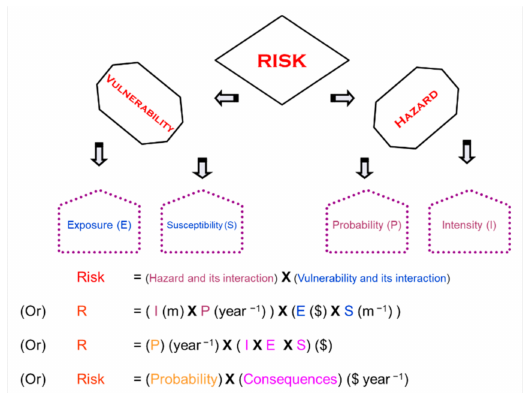
Figure 3. Graphical explanation of risk into its components and demonstration equivalency of di ff erent definitions of risk (source